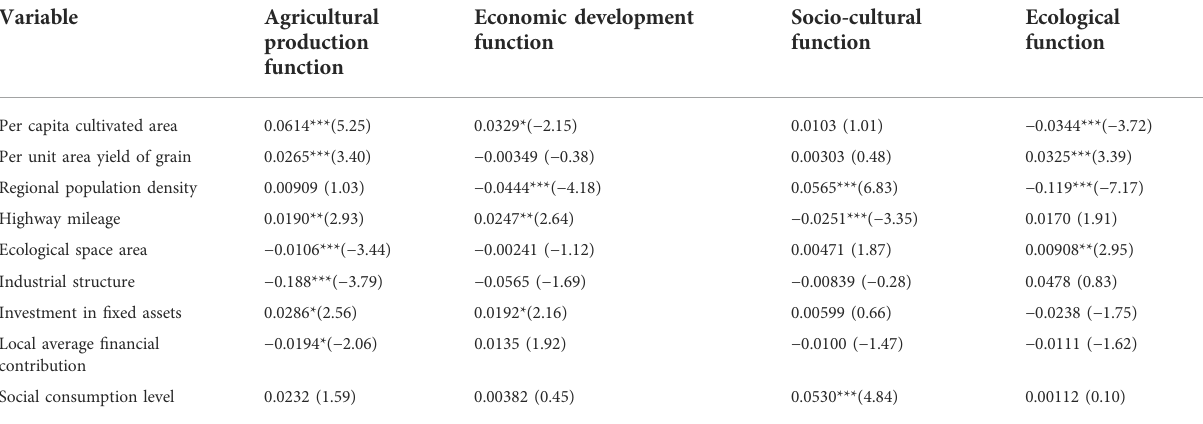
TABLE 5 Results of spatial error